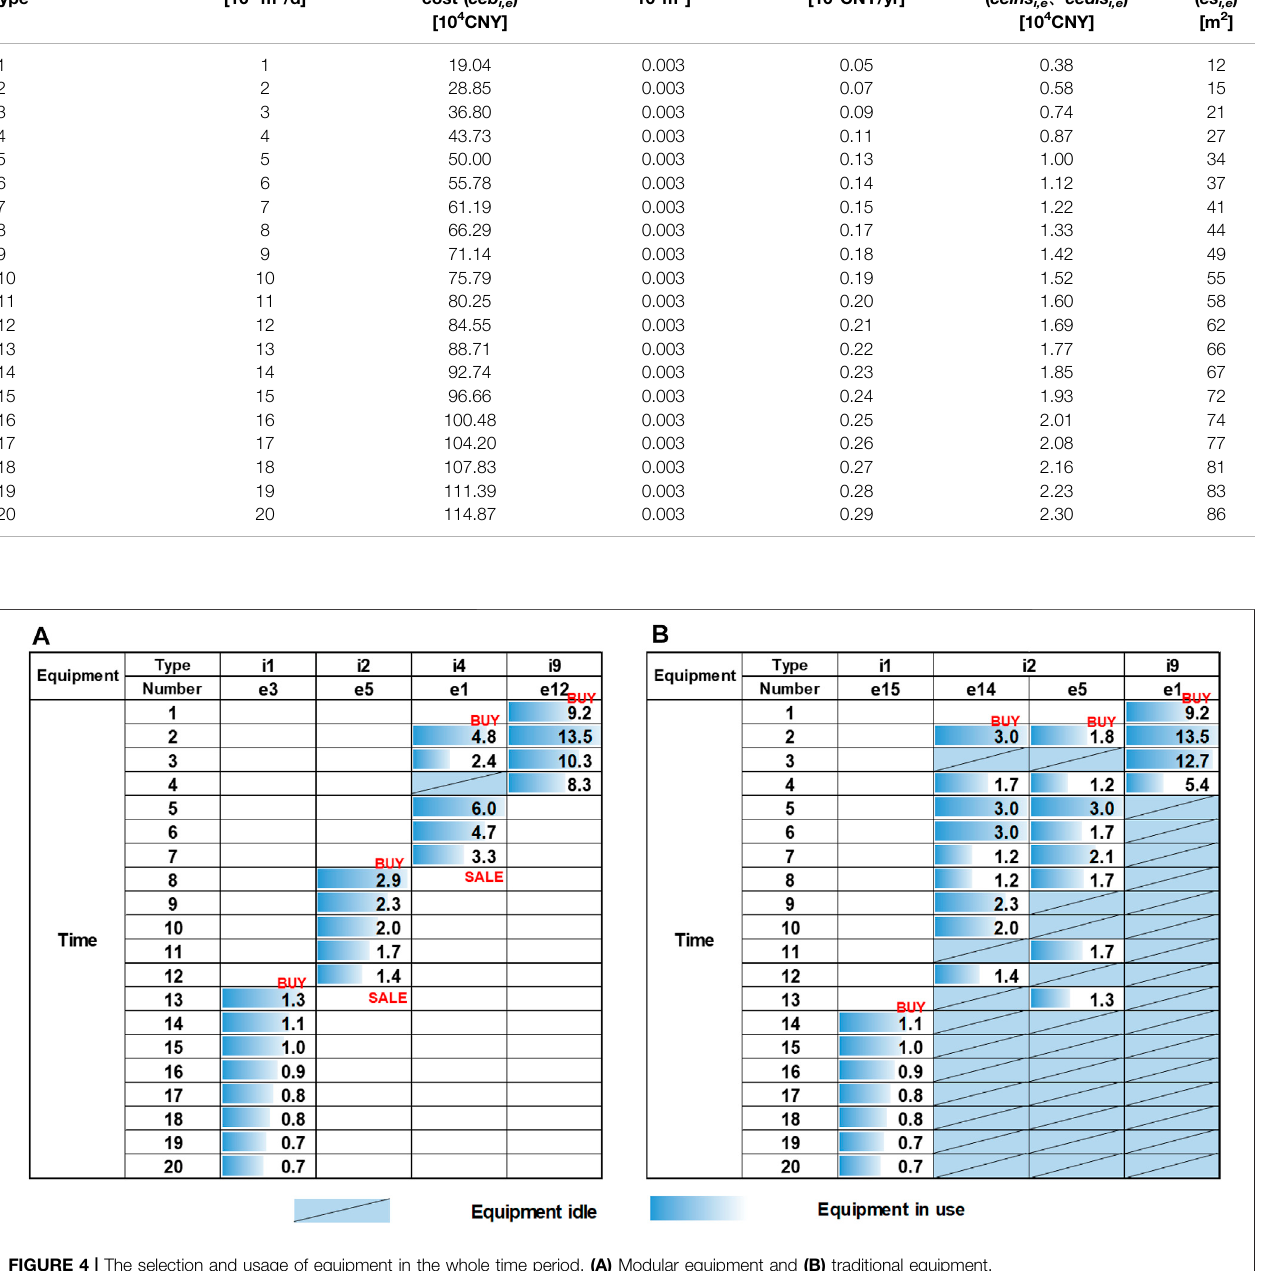
Frontiers in Energy Research |